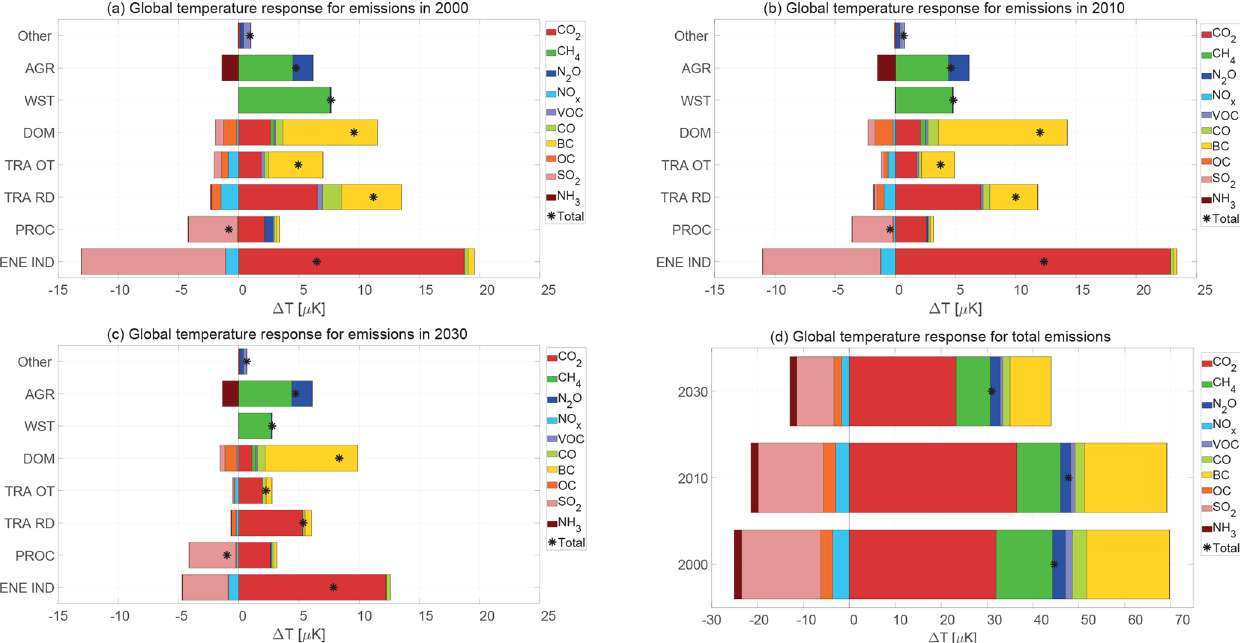
Figure 4. The temperature response (µK) due to emissions in 2000 (a) , 2010 (b) and 2030 (c) from energy and industry sectors (ENE IND), industrial processes (PROC), road transport (TRA RD), off-road transport and machinery (TRA OT), domestic (DOM), waste (WST), agriculture (AGR) and other (OTHER). The sum of all sectors is shown in (d) . The climate metric applied is the global mean ARTP (1–25 years) for pulse